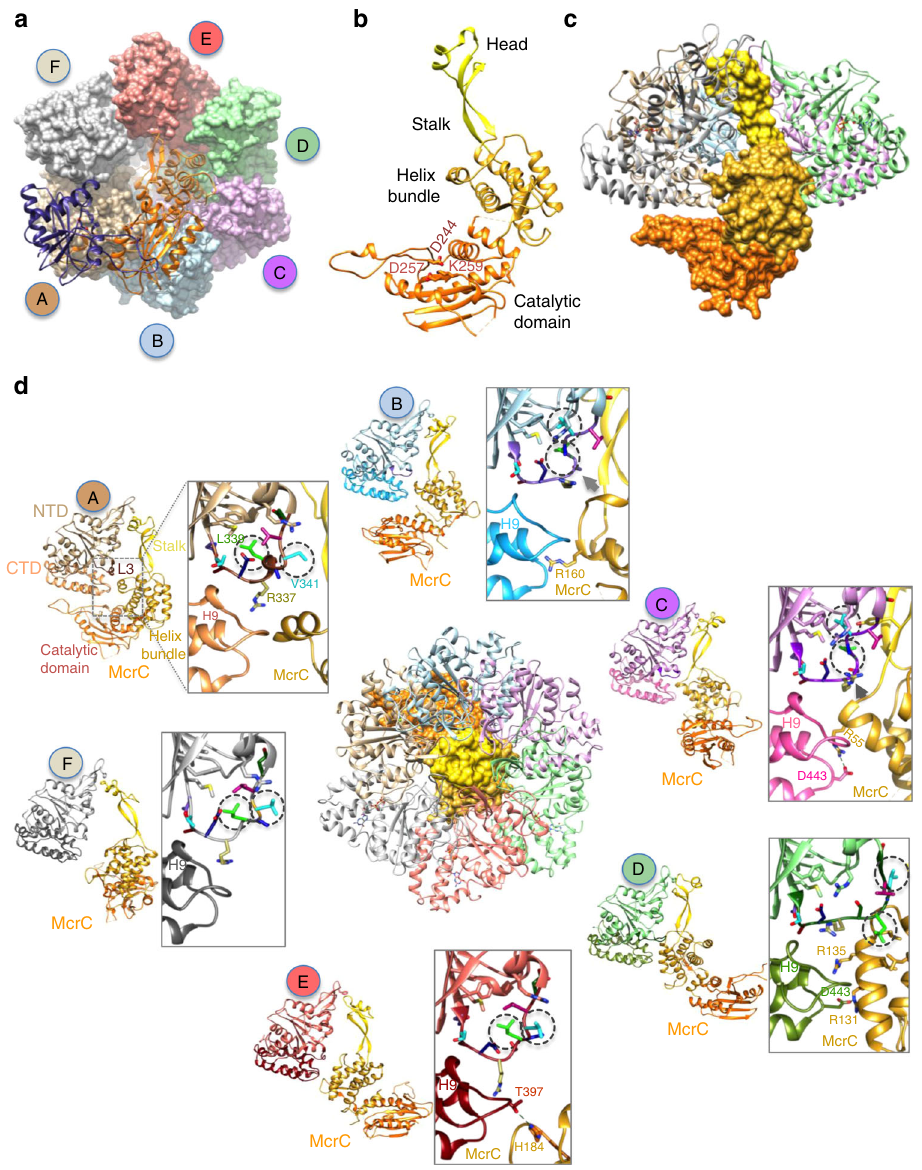
Fig. 3 Remodeling of McrB Δ N by McrC. a The dimer of McrC (ribbon representation) in complex with McrB Δ N hexamer (surface representation). Note that this view looks at the face of the ring opposite to that in Fig. 1d. b The structure of an McrC monomer with the nuclease catalytic residues highlighted. c The asymmetric interaction of a monomer of McrC with McrB Δ N hexamer. For clarity, protomer E of McrB Δ N has been hidden. d Structure of McrB Δ NC with the pore of the ring blocked by McrC is shown in the center. Around this fi gure, the interactions between McrC and the six McrB Δ N protomers are illustrated. The inset is a zoom of the interactions between the helix bundle of McrC and L3 and C-terminal domain of McrB Δ N protomers, highlighting the McrC-mediated remodeling of L3 in subunits A, B, C and D. The side chains of L3 residues are colored differently. Note the change in position of McrB- V341 (turquoise) and McrB-L339 (green), marked in dashed circles. The steric interaction between the helix bundle of McrC and L3 of B and C subunits are indicated by arrows